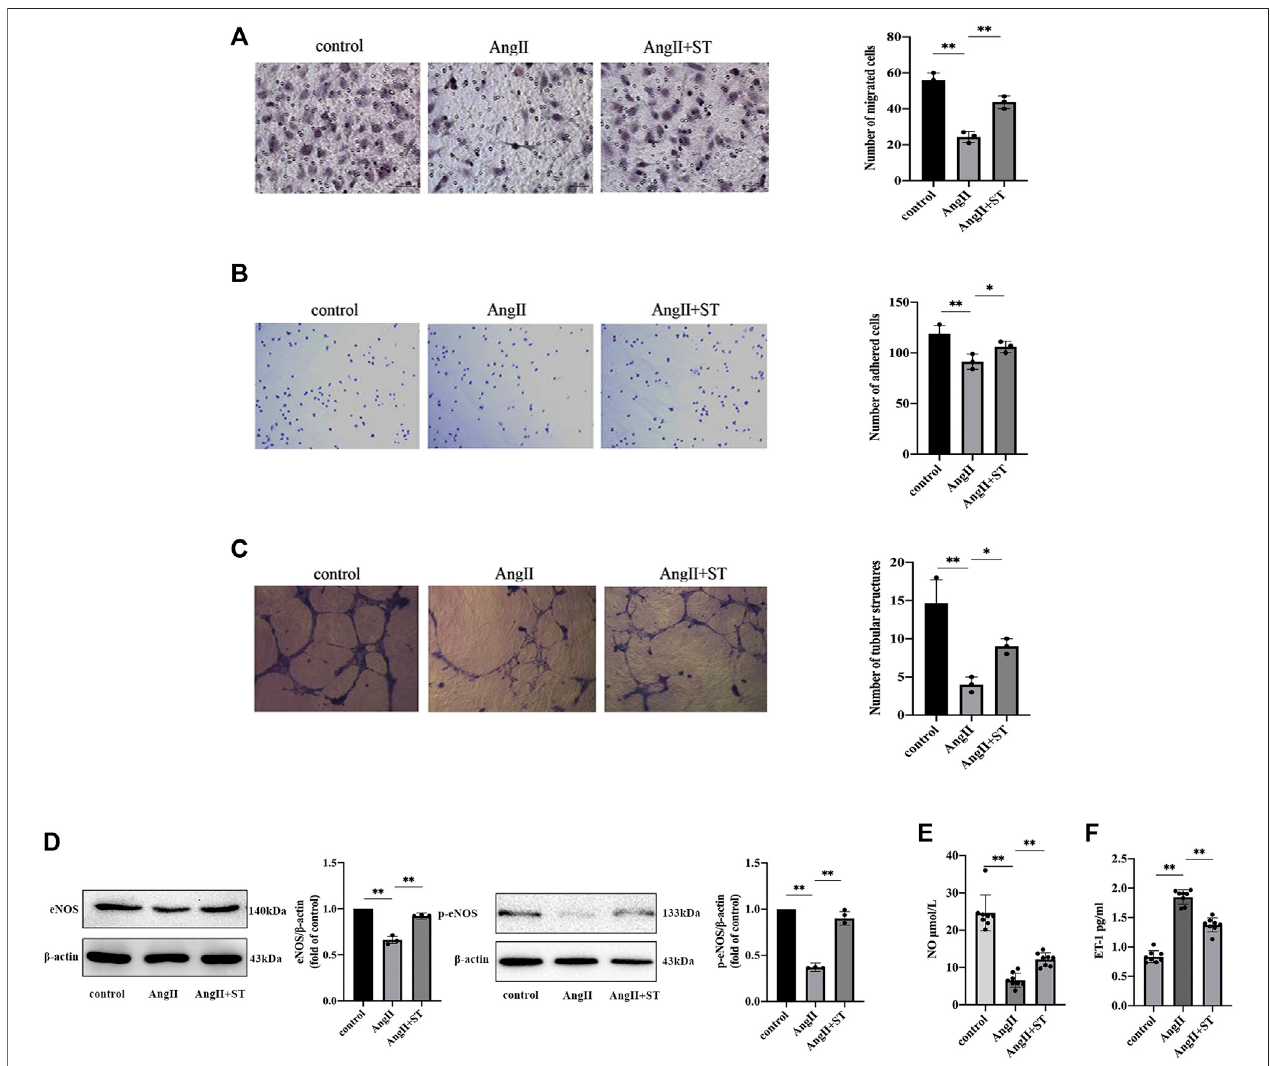
FIGURE 4 | ST attenuated Ang Ⅱ -induced HUVECs dysfunction. (A) Representative images and quantitative analysis of migration assay (HE stain, 100 × ). (B) Representative images and quantitativeanalysisofadhesion assay (HEstain, 100 × ). (C) Representativeimagesand quantitative analysisof tube formation assay invitro (200 × ). The number of tubular structures in the fi eld represented the angiogenesis capacity of vascular endothelia. (D) Western blot analysis of eNOS and p-eNOS expression incontrol,Ang Ⅱ andAng Ⅱ +STgroups. Thedatawerepresented infoldofcontrol. (E) ELISAanalysisofthelevelofNOinabovethreegroups. (F) ELISA analysis of the level of ET-1 in above three groups. All data except ELISA analysis were shown as mean ± SD (error bars) from three independent biological repeats experiments, each of which included three technical repeats. * p < 0.05; ** p < 0.01.